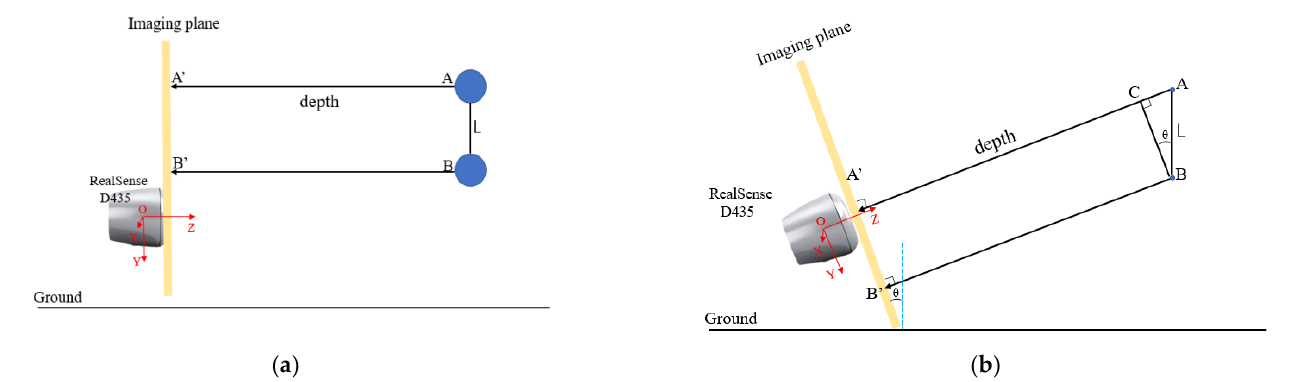
Figure 14. Relationship between depth value and camera tilt angle. ( a ) No depth difference occurred, and ( b ) depth difference occurred.